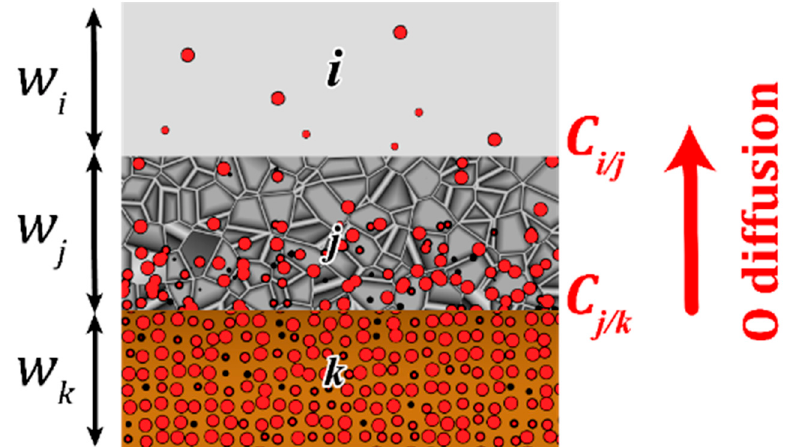
Figure 1. Schematic of the model-system: copper oxide layer W k (in orange), alumina barrier layer W j (in dark grey) and aluminum W i (in light grey). Oxygen diffusion across the interface is schematized with red balls.